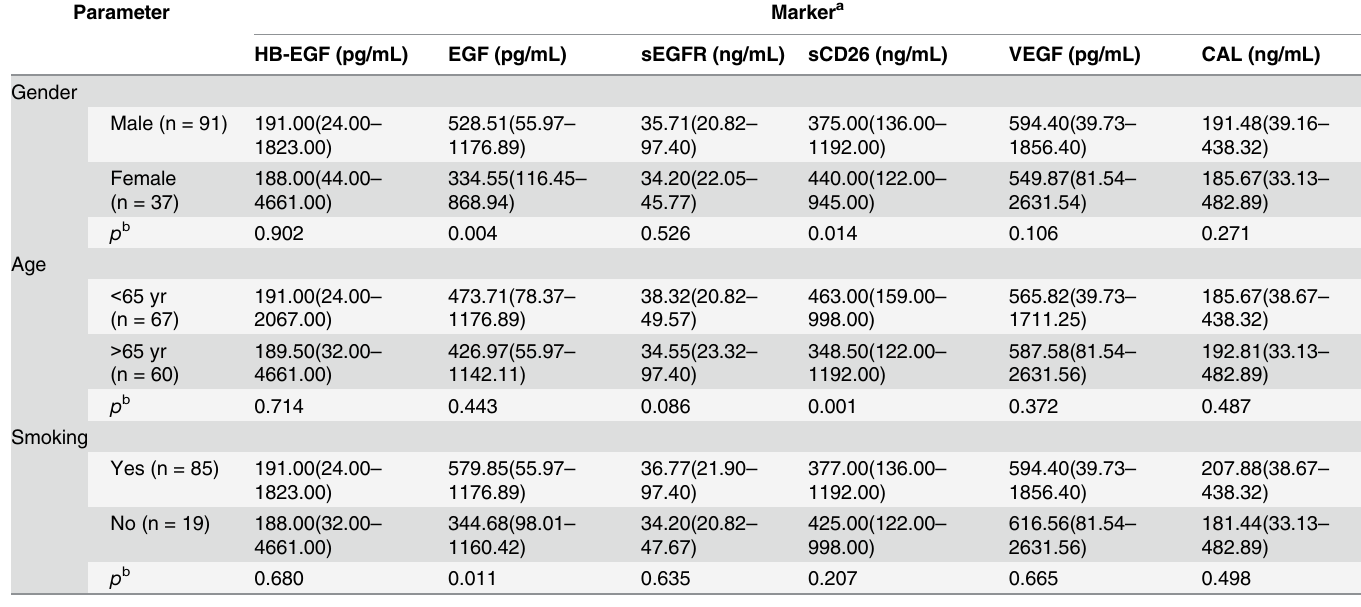
Table 3. Relationship between marker levels and demographic parameters. .